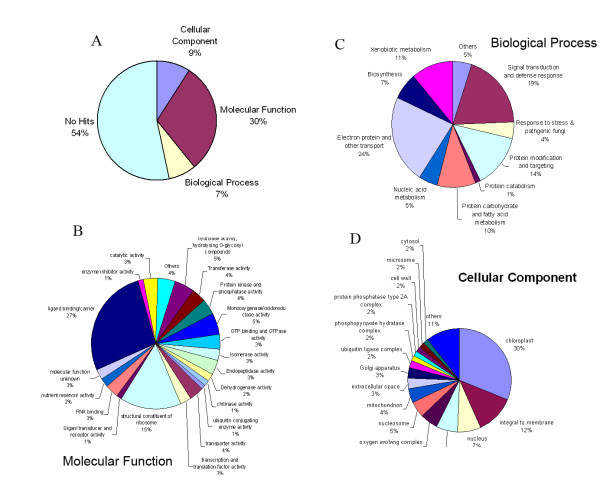
Percentage representation of gene ontology (GO) mappings for the 9621-67 and 9621-94 hybrids clusters. Functional annotation was carried using the High Throughput Gene Ontology Functional Annotation (Ht-Go-Fat) toolkit. The pie diagrams show the distribution of 905 sequences among the three principal GO categories. EST distribution (A) among the three GO principles (B) Molecular Function (C) Biological Process (D) Cellular Component.